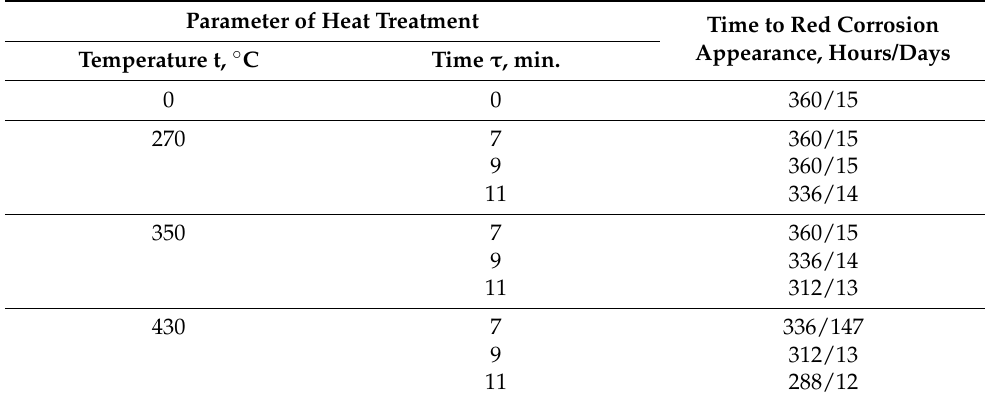
Table 4. Values of the heat treatment parameters and corrosion resistance of zinc coating after HT.